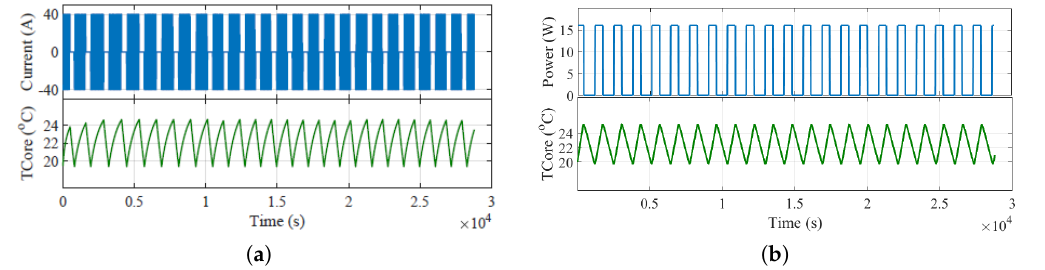
Figure 7. Simulation results for 0 ◦ C ambient temperature with ( a ) the APC method; ( b ) the HP. Current (blue) and battery cell’s core temperature (green) maintained between 20 ◦ C and 25 ◦ C.